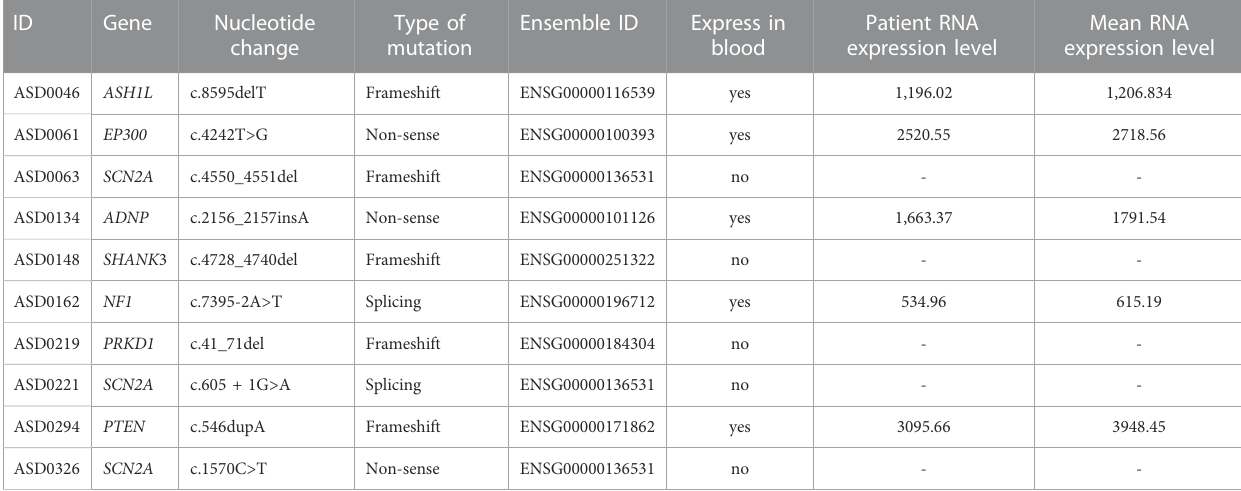
TABLE 5 RNAseq results of positive SNVs detected in this ASD